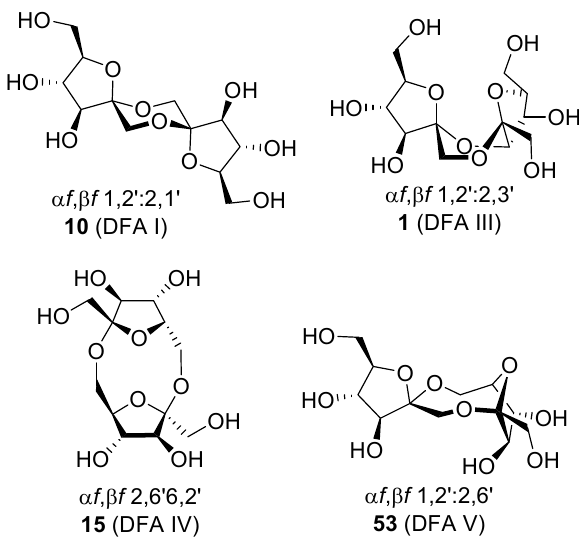
Figure 15 . DFA isomers available by biosynthetic